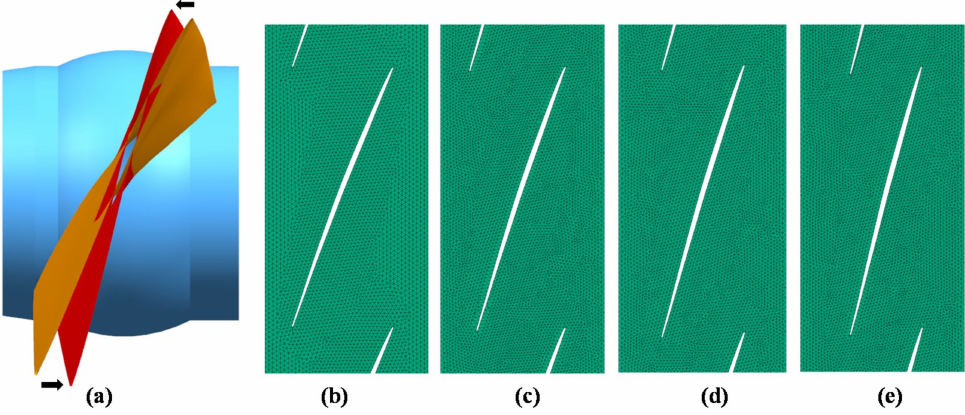
Figure 5. ( a ) Closing process of the blades, ( b ) t = 0 s, ( c ) t = 4.2 s, ( d ) t = 6.4 s, and ( e ) t = 9.2